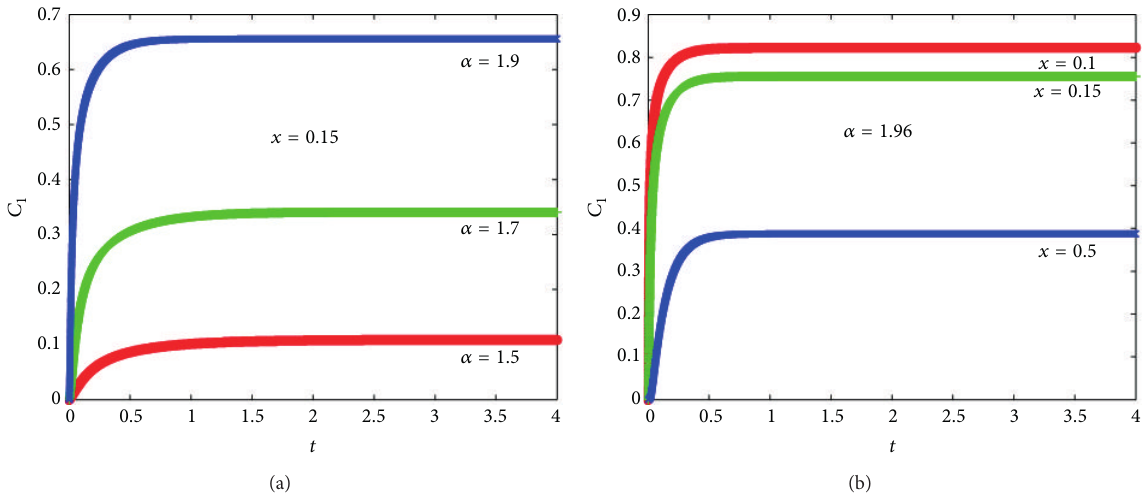
Figure 6: (a) is 𝐶 1 , plotted against 𝑡 at 𝑥 = 0.15 for different values of 𝛼 ; (b) is 𝐶 1 , plotted against 𝑡 at different 𝑥 when 𝛼 = 1.96 , 𝐴 = 0.4